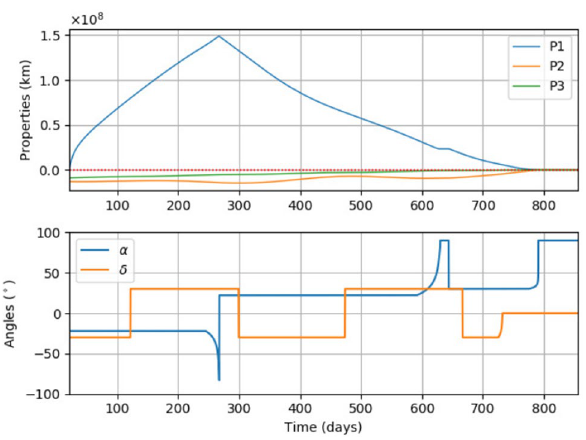
Figure 14. Sail properties for a tof of 855 days and sail loading of 164.7 g / m 2